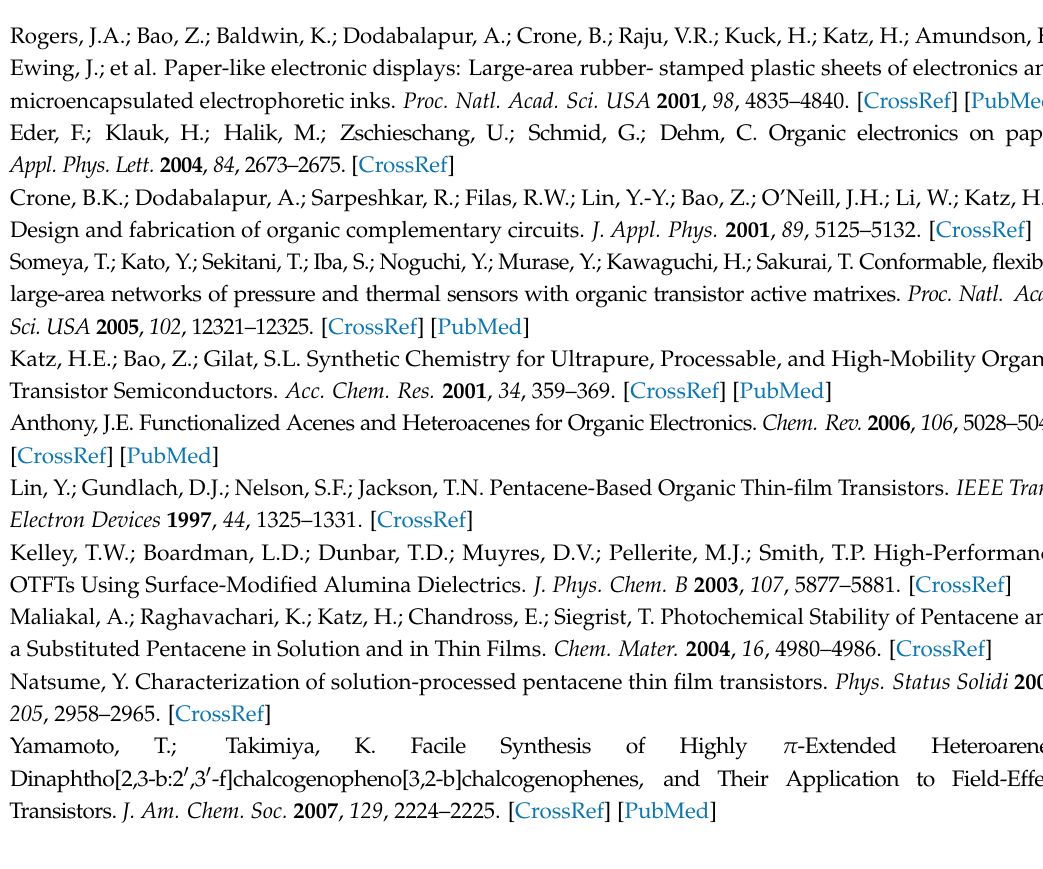
Figure S1: Graphical representation of vibrating atoms at (a) 1242.5 cm − 1 (peak 3), (b) 1327.8 cm − 1 (peak 4), (c) 1441.1 cm − 1 (peak 7), (d) 1635.6 cm − 1 (peak 12), and (e) 1660.5 cm − 1 (peak 13); Video S1, S2, S3, S4, S5, S6, and S7: Vibrational mode at 1242.5 cm − 1 (peak 3), 1327.8 cm − 1 (peak 4), 1441.1 cm − 1 (peak 7), 1538.5 cm − 1 (peak 10), 1600.1 cm − 1 (peak 11), 1635.6 cm − 1 (peak 12), and 1660.5 cm − 1 (peak 13),